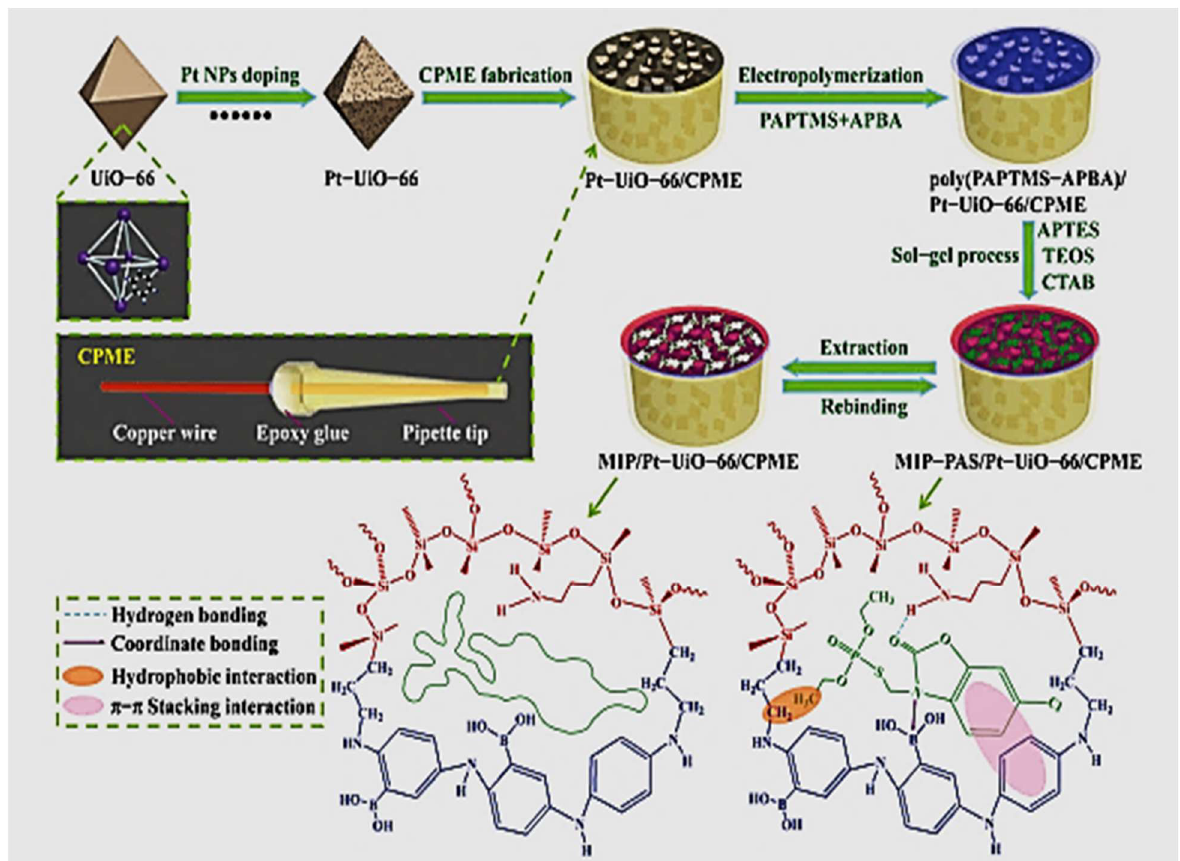
Figure 6. Schematic representation of the template extraction-rebinding concept and the production of MIP films on Zr-based metal–organic framework catalyst (Pt-UiO-66)/carbon paste microelectrode [119]. (RSC open access content, further permissions related to this figure should be directed to the RCS, doi:10.1039/d0an00278j).